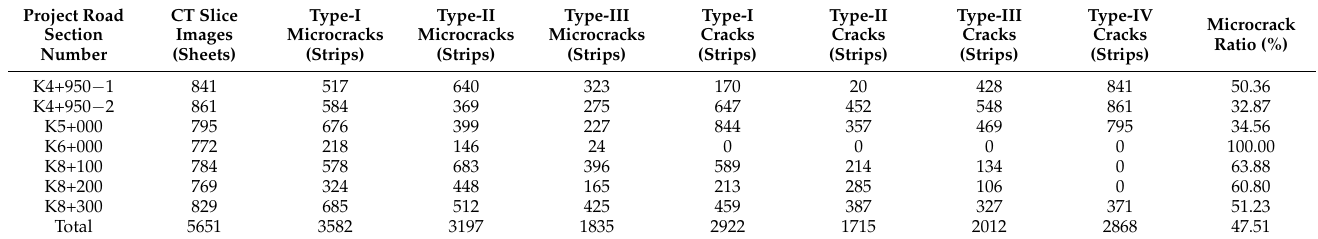
Table 2. The number of